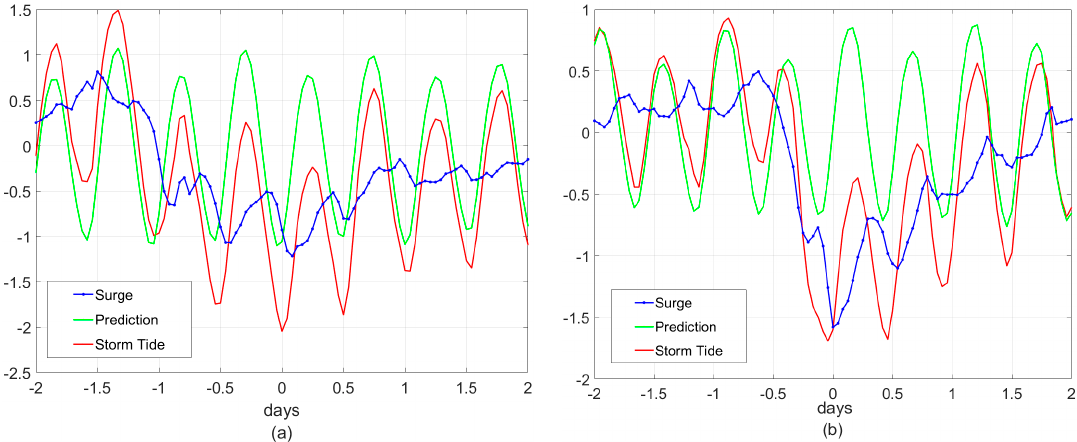
Figure 2. Time Series of water level in m ( a ) at The Battery for an Extra Tropical Cyclone (ETC) on 1 / 10 / 1978 with the historically largest extreme low water (ELW); and ( b ) at Governor’s Island for an ETC on 2 / 25 / 1862 with the historically largest negative surge. “Prediction” is the astronomical tide prediction.